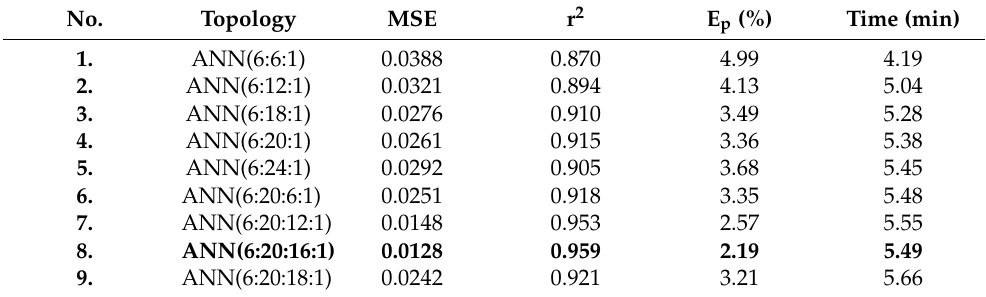
Table 1. Topology and performance of different ANNs constructed and trained for CO prediction.